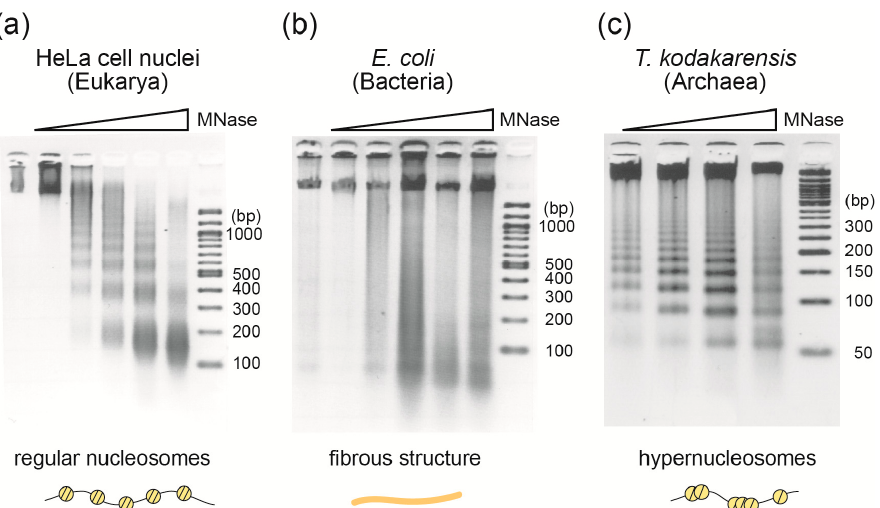
Figure 3. MNase assay revealed different fundamental chromatin structures among the three do- mains. Different cells from the three domains were treated with MNase in increasing amounts, and the resulting DNA fragments were separated on agarose gels. Schematic representation of the structure implied by each result is shown below the image. ( a ) Nuclei of HeLa cells fixed in 1% formaldehyde; ( b ) E. coli cells fixed with 1% formaldehyde; ( c ) Extracted T. kodakarensis chromatin. The size of the DNA ladders is shown on the right side of each gel.